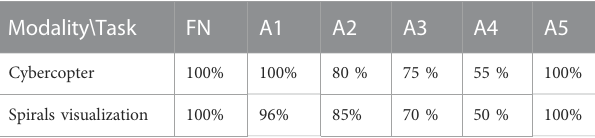
TABLE 2 Success rates for alerts classi fi cation. Modality ∖ Task